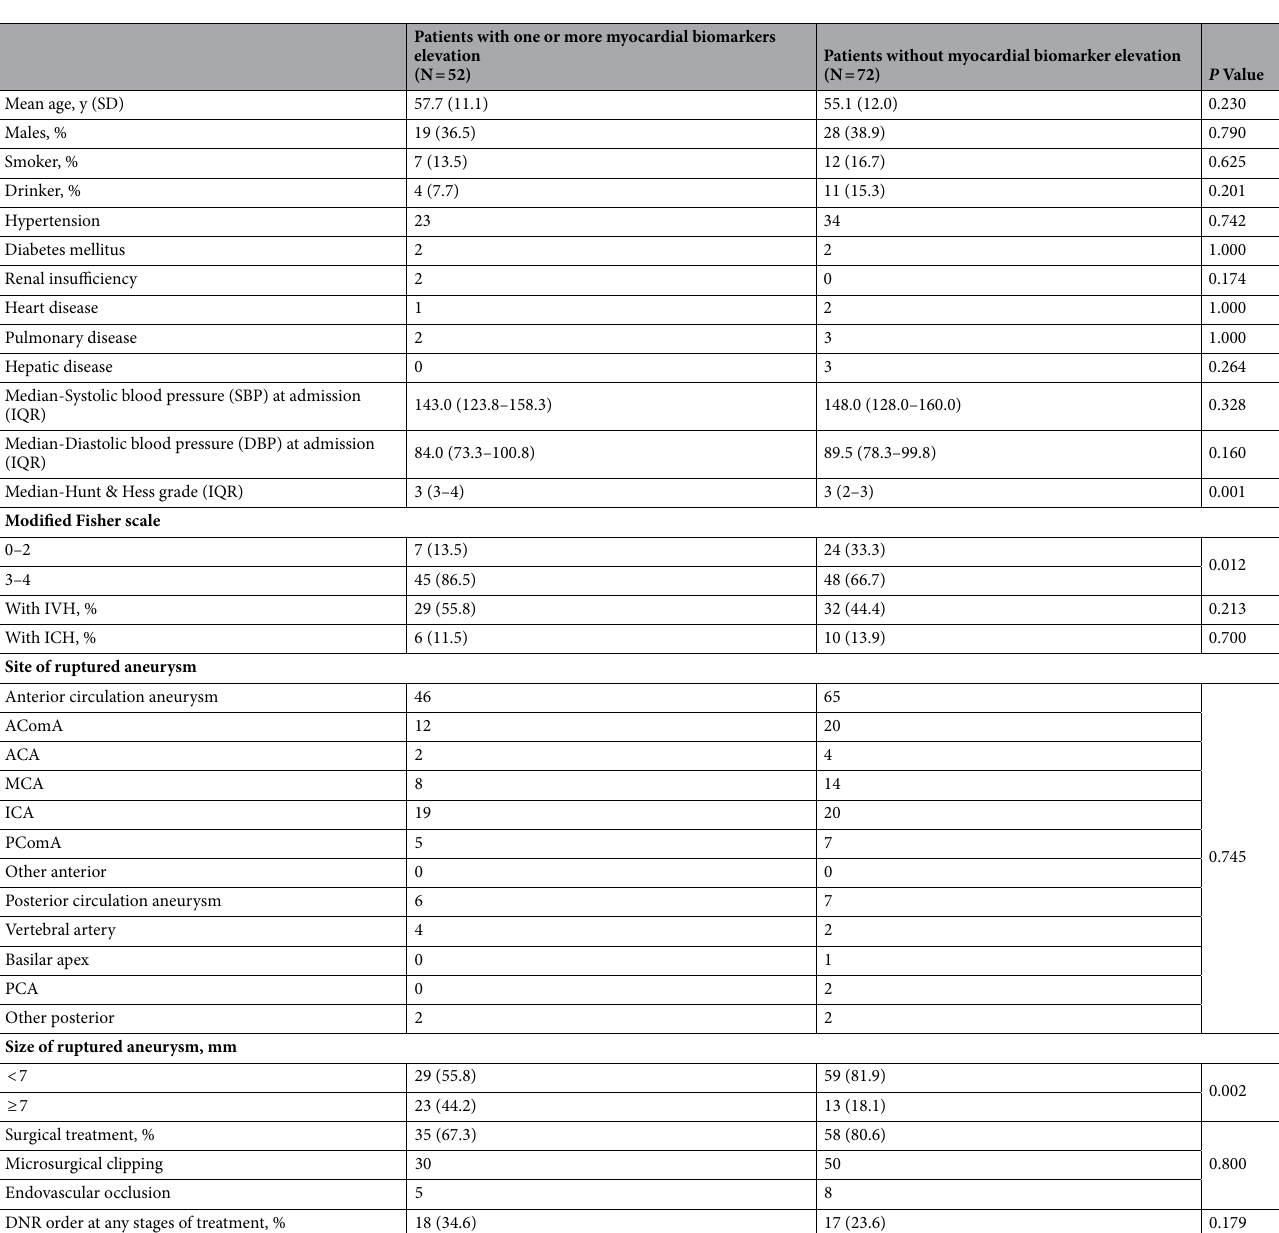
Table 1. Clinical Characteristics of Enrolled Patients. ACA anterior cerebral artery, AComA anterior communicating artery, DNR do not rescue, ICA internal carotid artery, ICH intracerebral hemorrhage, IVH intraventricular hemorrhage, MCA middle cerebral artery, PCA posterior cerebral artery, PComA posterior communicating